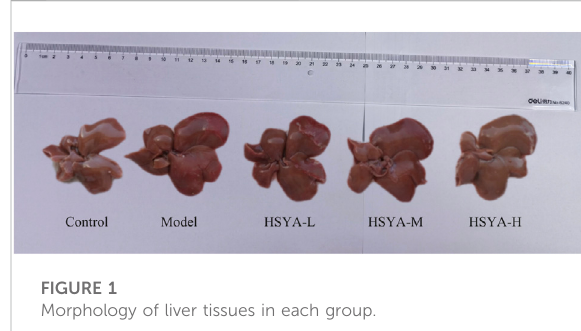
FIGURE 1 Morphology of liver tissues in each